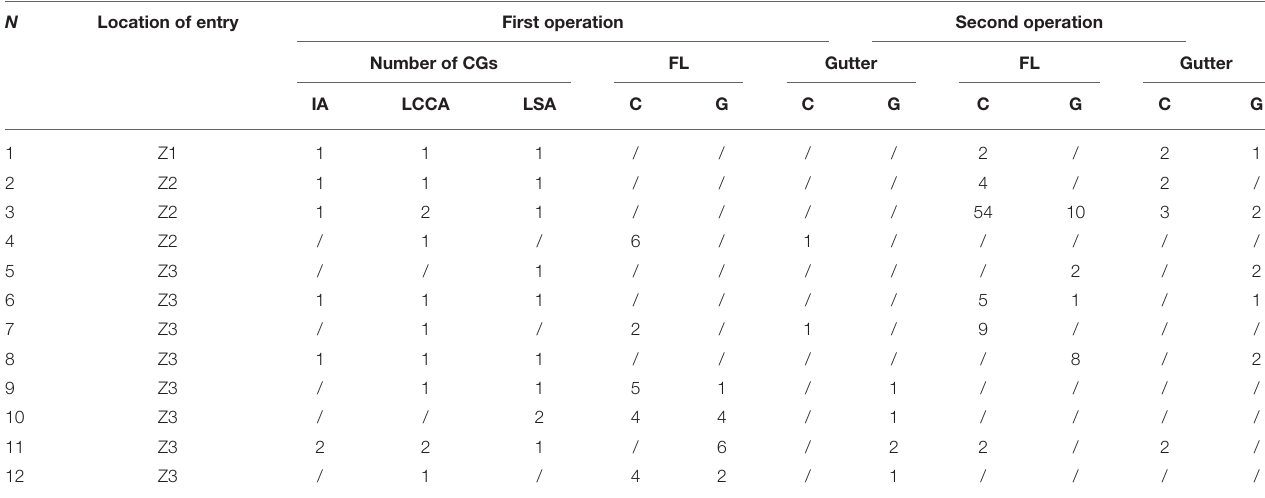
TABLE 2 | Treatment strategy according to the location of